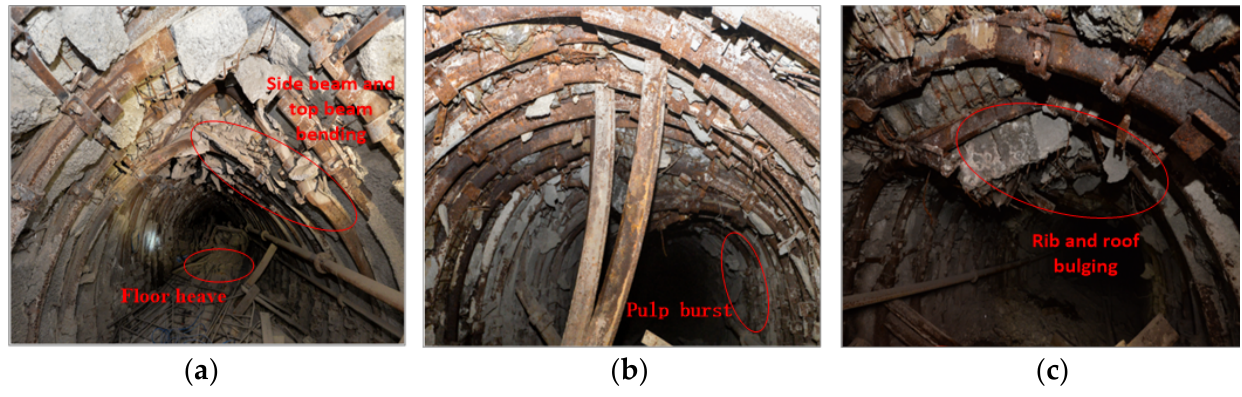
Figure 2. Roadway damage in test section. ( a ) Floor heave and side-beam and top-beam bending; ( b ) Pulp burst; ( c ) Rib and roof bulging.